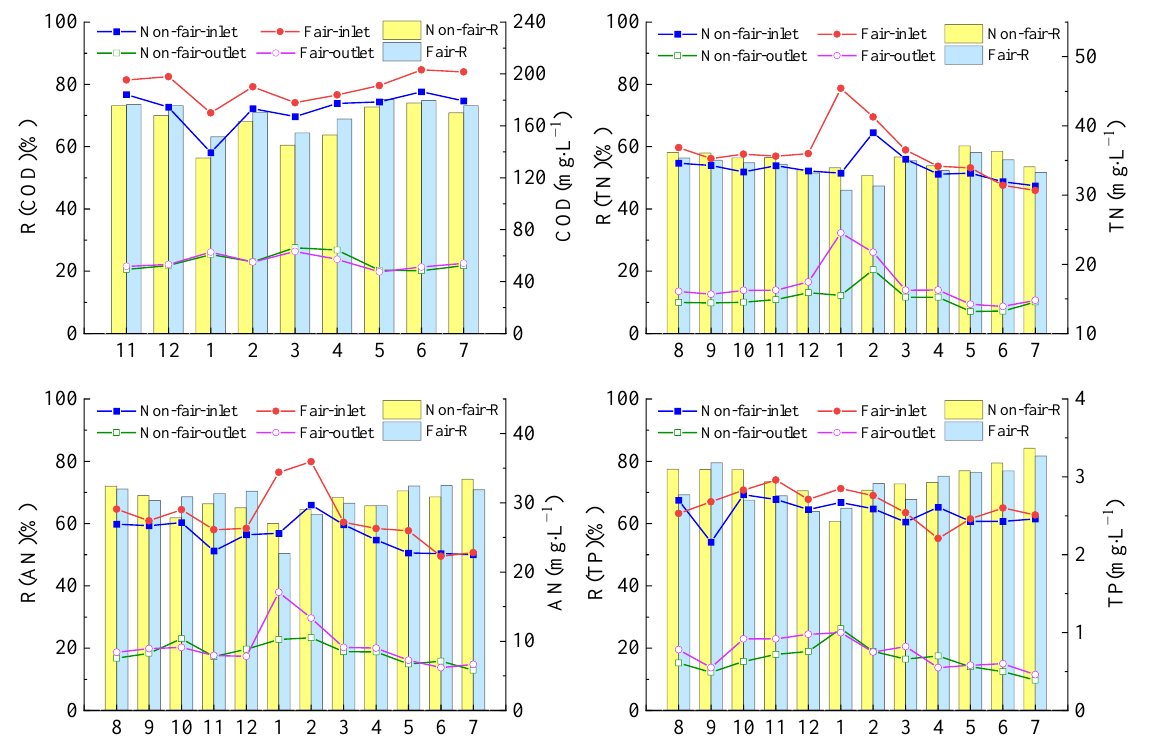
Figure 3. Removal capacity of the TIEPD under different rural life events. Under different precipitation intensities, the pollutant concentrations in the outlet were significantly lower than those in the inlet (Figure 4). The average outlet concentrations of COD, AN, TN and TP under different precipitation intensities all met the requirements of the class 1 B standard in the DSP of China. One-way ANOVA showed that there were no significant differences between the concentrations of COD, TN and TP under different rural life events ( p > 0.05). The concentration of AN on heavy rain days was significantly different from that on light rain and moderate rain days ( p < 0.05). On the light rain days, the average removal efficiencies of COD, AN, TN and TP were 69.84 ± 6.58%, 68.68 ± 6.71%, 56.3 ± 7.41% and 69.31 ± 11.11%, respectively. On moderate rain days, the average removal efficiencies of these indices were 73.07 ± 4.48%, 66.91 ± 6%, 56.27 ± 5.23%, 75.77 ± 8.93%, respectively. Additionally, they were 73.94 ± 2.54%, 69.85 ± 12.16%, 48.41 ± 10.68%, 79.43 ± 6.04%, respectively, on heavy rain days. Moreover, the differences in the removal efficiencies of COD, AN, TN and TP between different precipitation intensities were not significant ( p > 0.05).